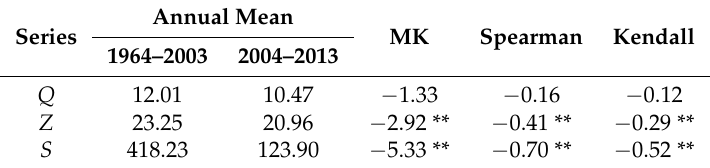
Table 2. Trend analysis of the three flood peak series at the Waizhou station during 1964–2013. Annual Mean Series MK Spearman Kendall 1964–2003